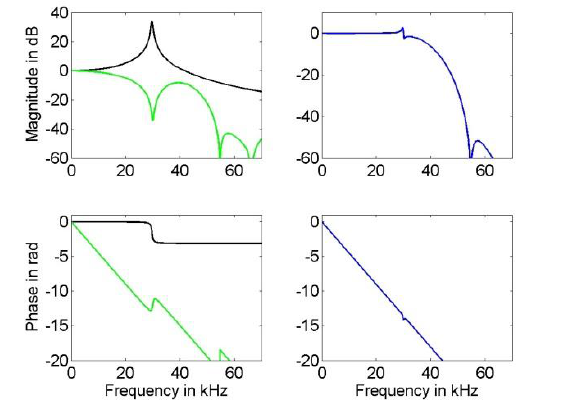
Figure 7. Left: Frequency response of the sensor model (black) with system parameter vector (11) and the FIR compensation filter (green) designed for the available estimate (12a) of the system parameter vector for estimation of the broad-banded (25 kHz) input signal. Right: Frequency response of the actual compensated